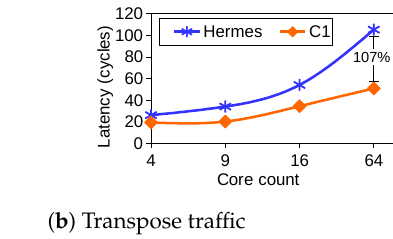
Figure 16. Scalability comparison of R-NoC C1 with Hermes [10]. 4: 2 × 2 mesh; 9: 3 × 3 mesh, 16: 4 × 4 mesh, 64: 8 × 8 mesh network. Latency: average network zero-load latency.